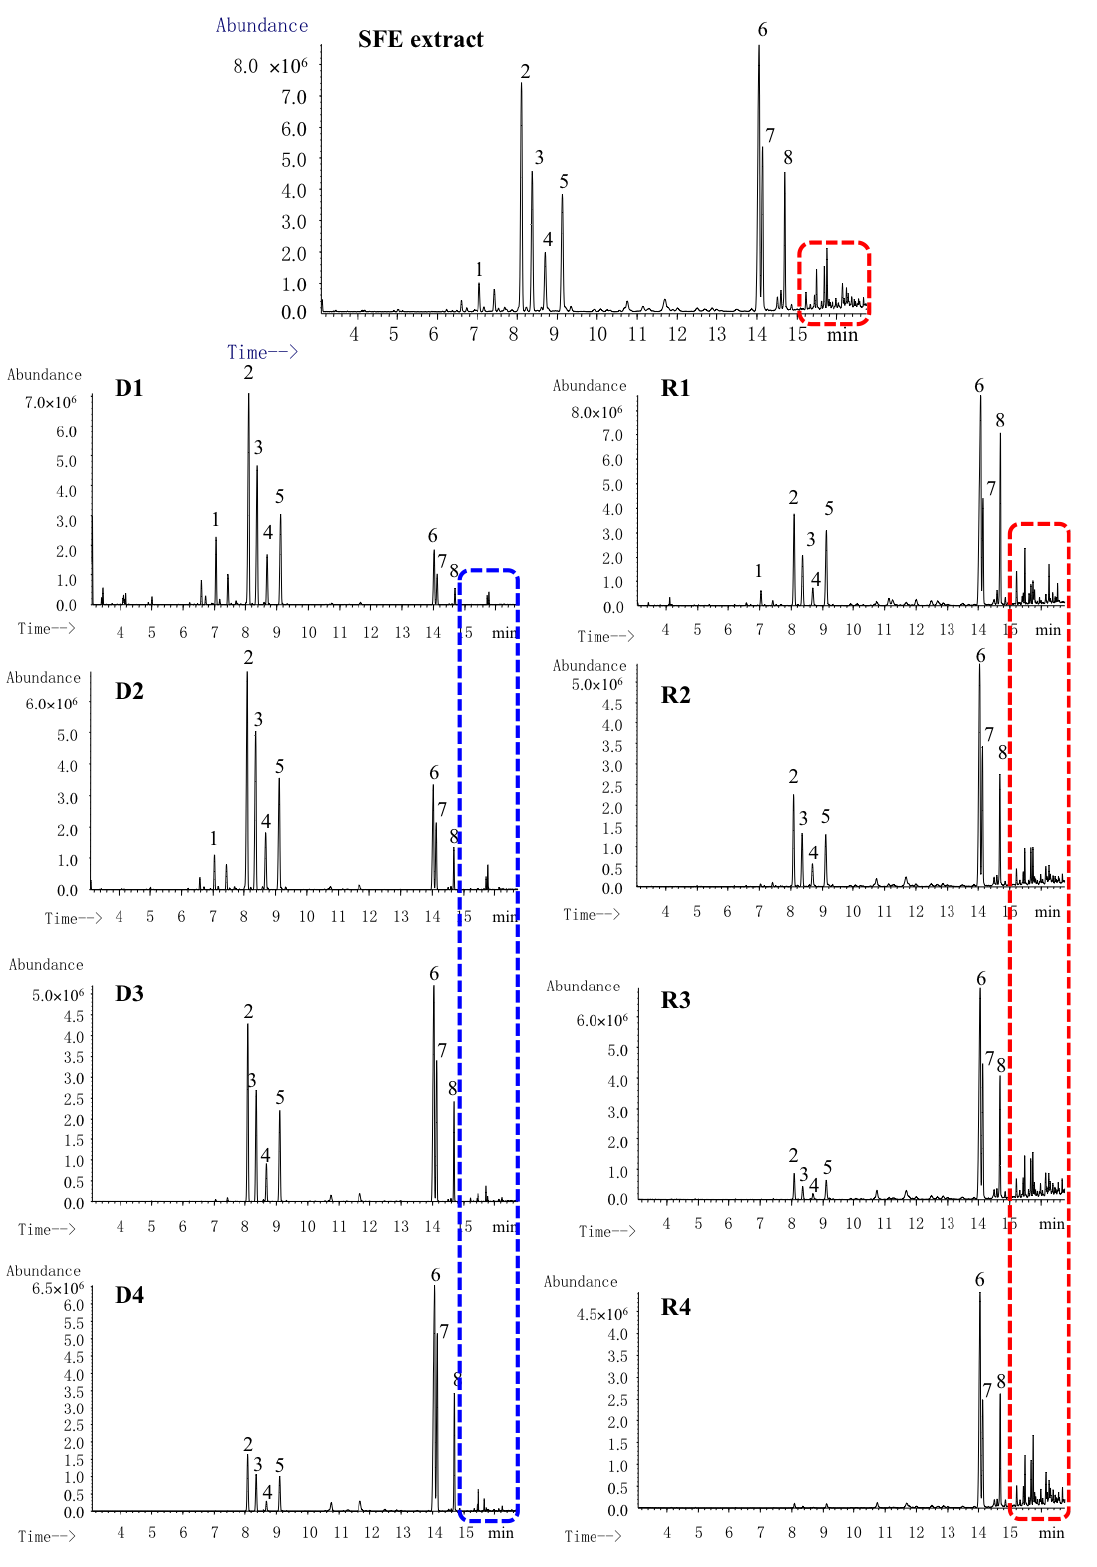
Figure 2. GC-MS total ion chromatograms of supercritical fluid extraction (SFE) extract and different distillates of molecular distillation. D1-4: Distillate 1-4, R1-4: Residue 1-4; 1. β-caryophyllene, 2. ar-curcumene, 3. zingiberene, 4. β-bisabolene, 5. β-sesquiphellandrene, 6. ar-turmerone, 7. α-turmerone, 8. β-turmerone.